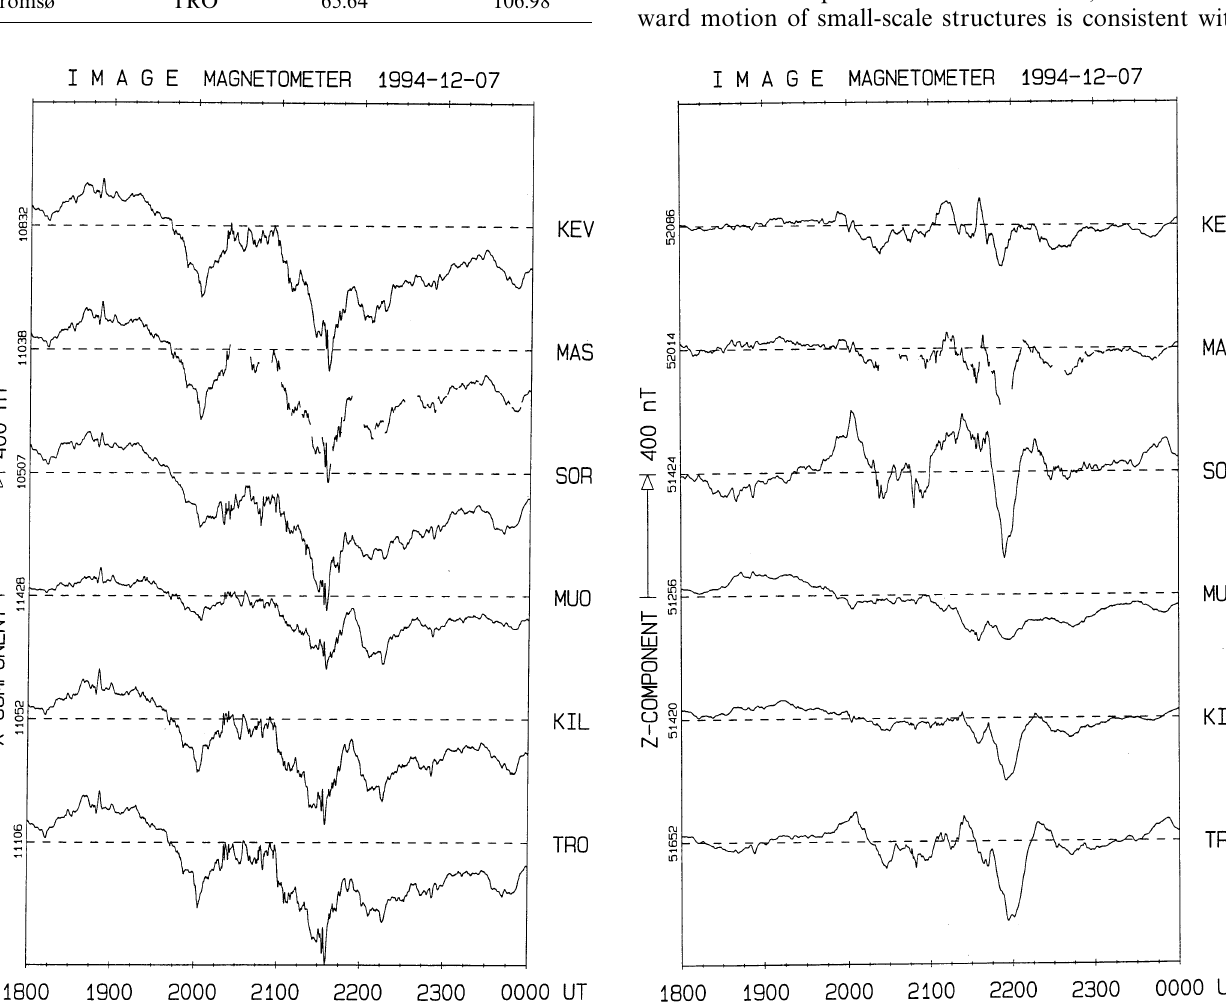
Fig. 2. Vertical component of the ground-magnetometer distur- bances at different IMAGE magnetometer chain stations on 7